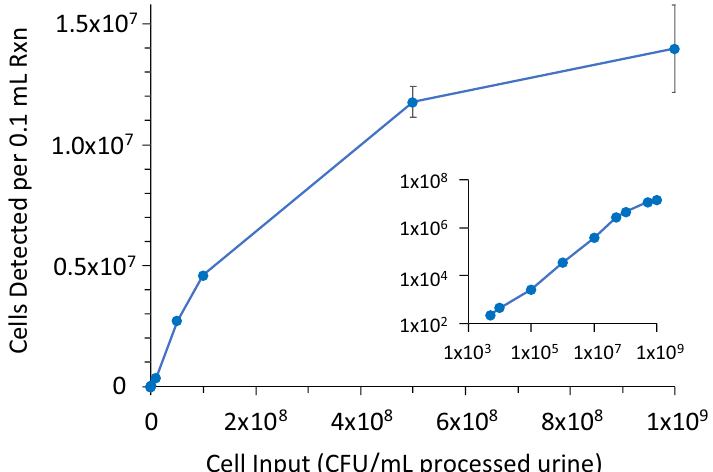
Figure 5. Analytical measuring interval of MultiPath E. coli assay. E. coli ATCC 25922 cells were grown to mid-log phase, concentrated, and diluted in SEC-processed urine at concentrations ranging from 5 × 10 3 to 1 × 10 9 CFU/mL. Detected cells were estimated from total fluorescence. Plotted data points are means of triplicate reactions. Error bars represent +/− 1 SD. The inset shows a log–log plot so all data points can be seen.